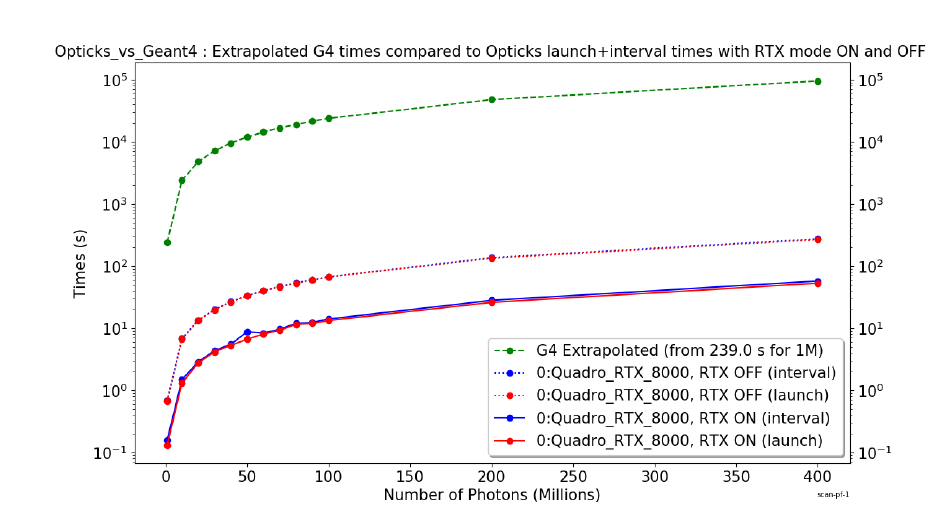
Figure 4. Full analytic JUNO geometry Opticks simulation times in seconds for 1M-400M optical photons using a single NVIDIA Quadro RTX 8000 GPU are compared with single threaded Geant4 10.4.2 simulation times extrapolated from a measurement for 1M optical photons. The solid(dotted) blue and red curves show times with RTX mode enabled(disabled). Di ff erences between interval times which include per event upload and download overheads and launch times are not readily apparent with the logarithmic scale. The linearly extrapolated Geant4 time for 400M photons is 95,600 s (26 hours) contrasts with the Opticks time of 58s, corresponding to a speedup factor of 1,660 times with a single